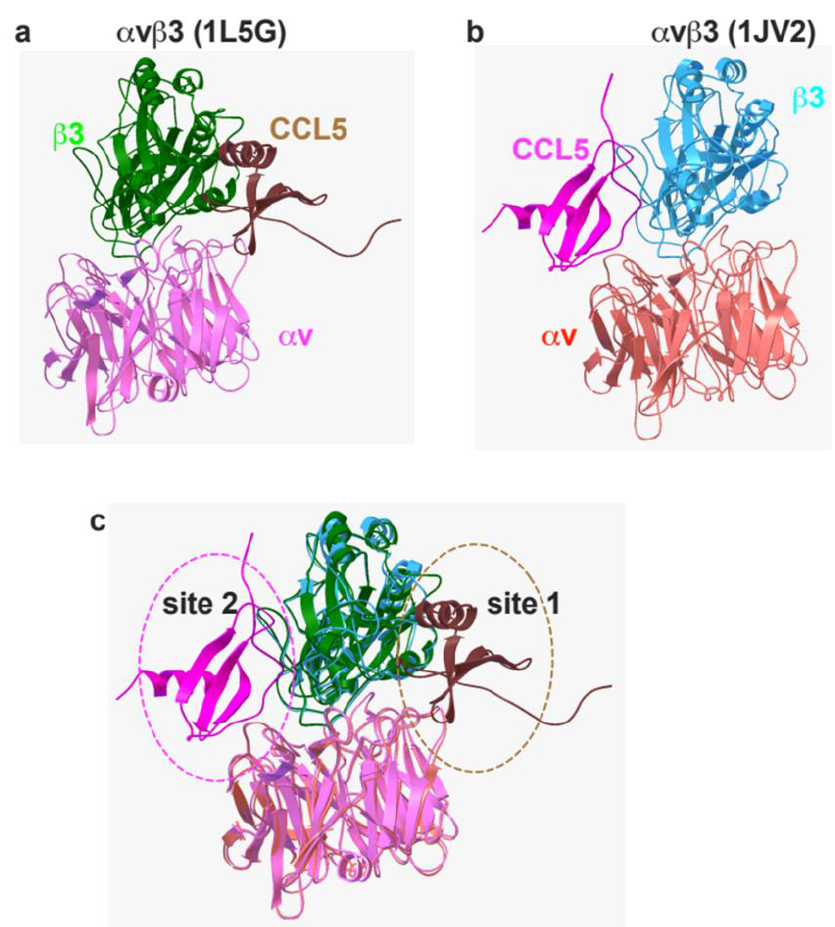
Figure 1. Model of the interaction between CCL5 and integrin αvβ3. Docking simulation between CCL5 (1EQT.pdb) and integrin αvβ3 ( a ) with open-headpiece conformation 1L5G.pdb or ( b ) with closed headpiece conformation, 1JV2.pdb using Autodock3, as described in the Methods section; the docking models were superimposed ( c ). Different colors indicate specific protein